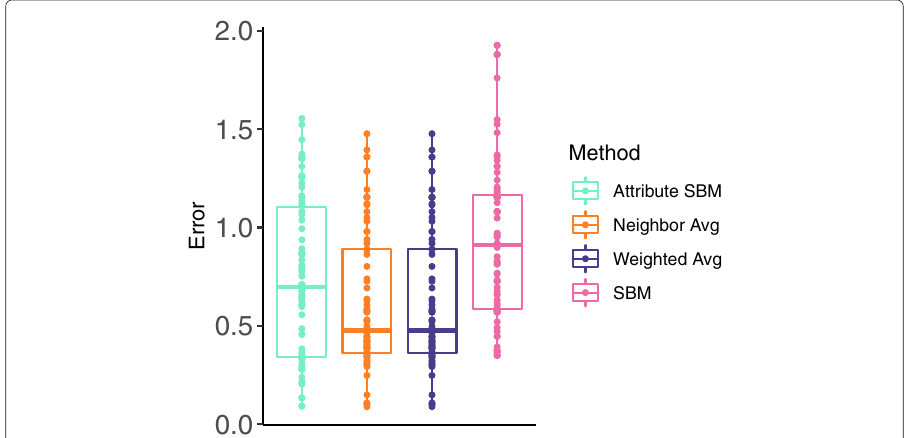
Fig. 7 Collaborative filtering in the protein interaction network. For each of the 82 nodes, we fit a model to the remaining 81 node network and given the node’s closest neighbors (based on network connectivity) sought to predict its 6-dimensional attribute vector. The reported error is the root mean squared error (denoted by E ) between the difference between the true attribute vector ( x i ) and its predicted attribute vector ( ˆ x i ) . The mean error in x i using the attributed SBM is 0.74, as opposed to the neighborhood average, weighted neighborhood average, and SBM, resulting in errors of 0.74, 0.62, 0.62, and 0.94,